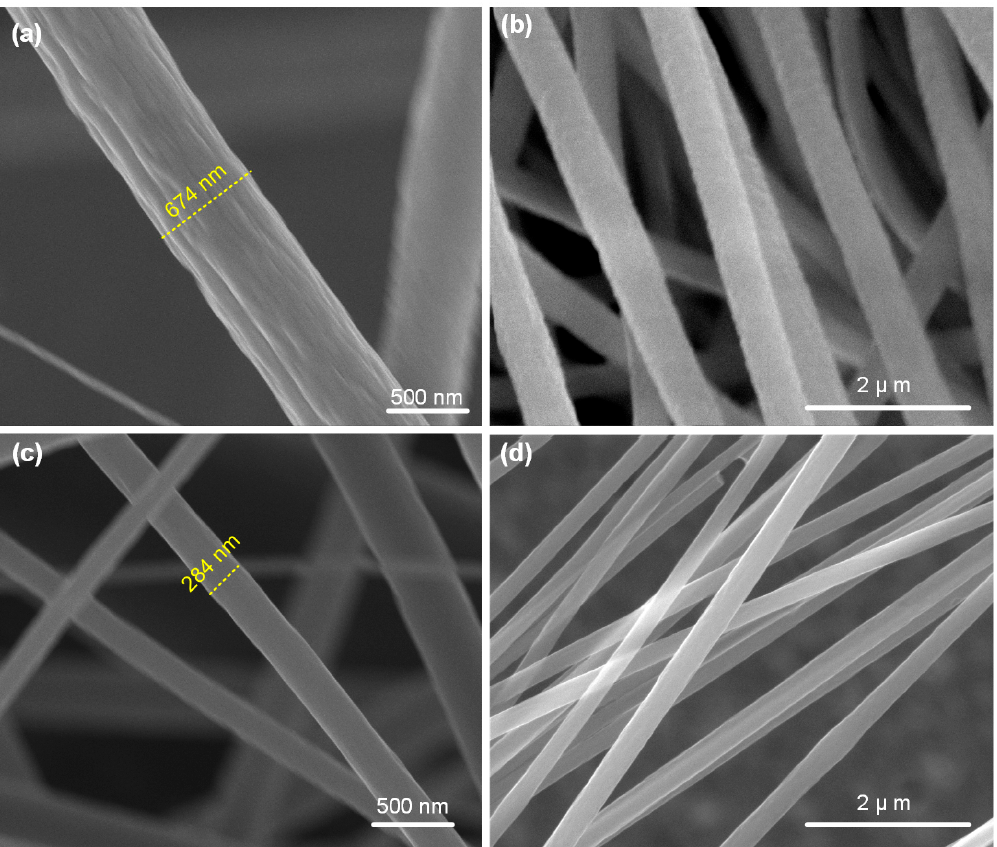
Figure 2. SEM micrographs of the electrospun nanofibers before and after carbonization: ( a , b ) Micrographs showing the as-spun PAN nanofibers at two different magnifications. The as-spun nanofibers were found to be uniform in diameter; ( c , d ) Micrographs showing the carbonized nanofibers with significantly reduced diameters.